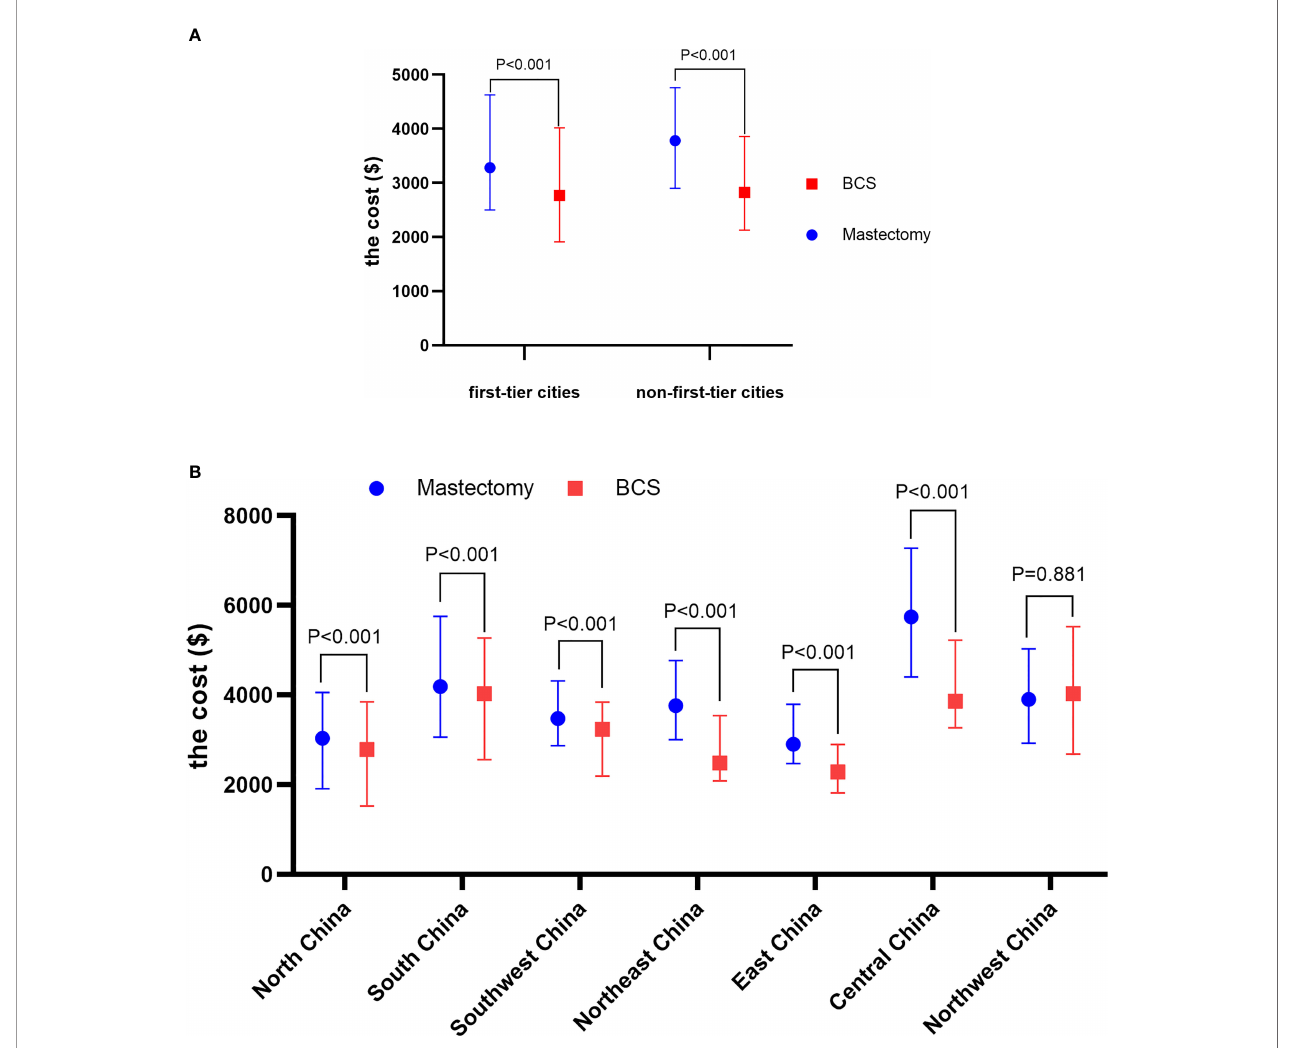
FIGURE 1 | The median cost of mastectomy and BCS of different city tiers (A) and regions (B) . BCS, breast-conserving